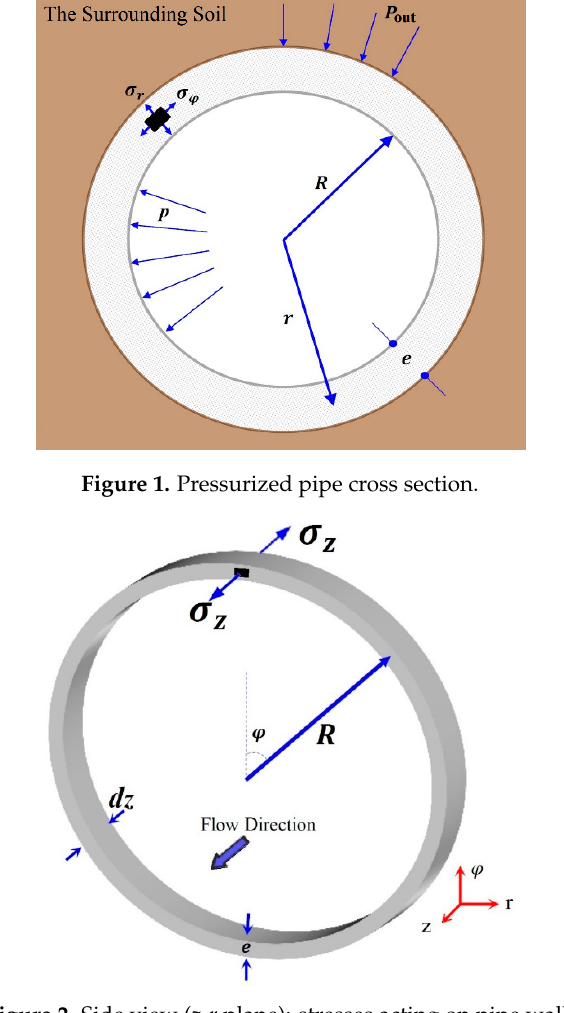
Figure 2. Side view ( z - r plane): stresses acting on pipe wall.